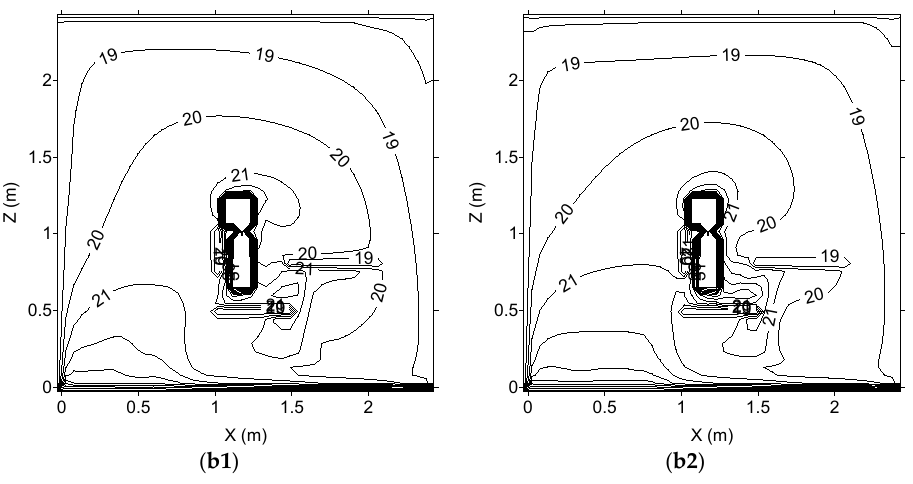
Figure 3. Air velocity ( a1,a2 ) and air temperature ( b1,b2 ) fields in the plan located at Y = 170 cm (Y34) (left side seated occupant), numerically calculated. ( a1,b1 ) are associated with the k ‐ epsilon turbulence model, and ( a2,b2 ) are associated with the RNG turbulence model.